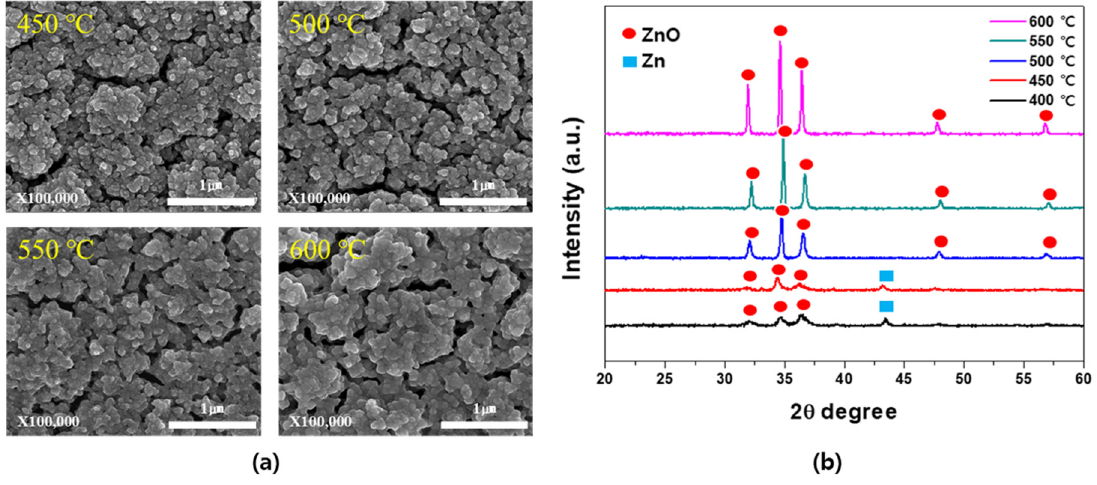
Figure 6. ( a ) Surface SEM images and ( b ) XRD patterns of the formed Zn-ZnO films upon variation in the oxidation temperature.